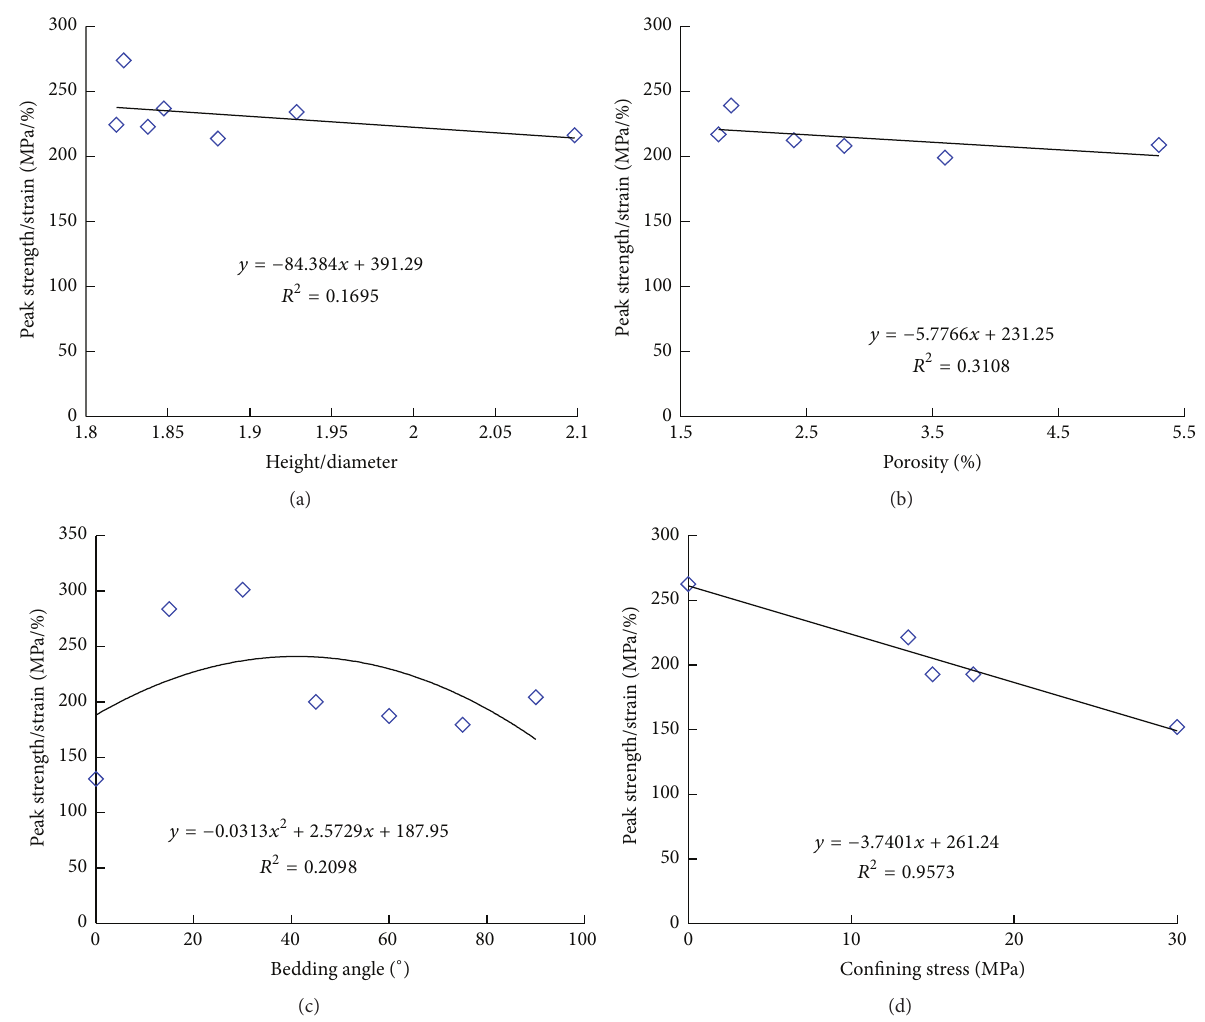
Figure 11: Correlation analysis: (a) height/diameter ratio versus peak strength/strain; (b) porosity versus peak strength/strain; (c) confining stress versus peak strength/strain; (d) bedding angle versus peak strength/strain.